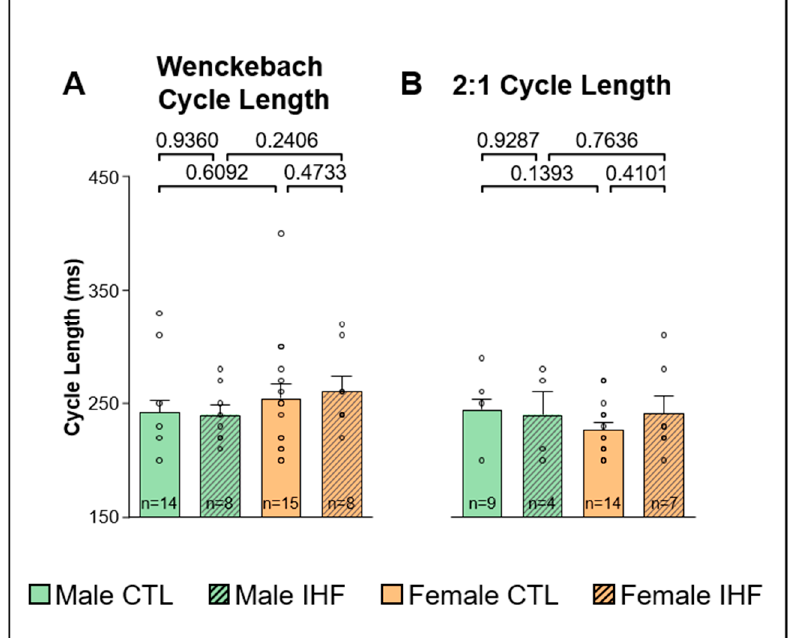
Figure 6. Atrioventricular conduction properties. ( A ), Wenckebach cycle length. ( B ), 2:1 atrioventric- ular conduction cycle length. CTL , control animals without ischemic heart failure; IHF , animals with ischemic heart failure. Bar graphs represent Mean + SEM, grey circles represent data of individual pigs. Mann-Whitney-U Test.